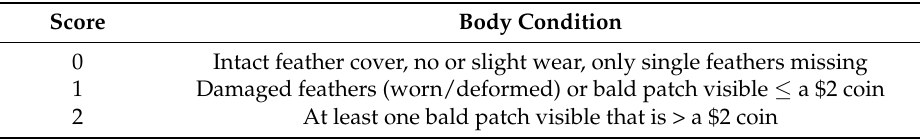
Table 1. The scoring system used by farmers on-site to evaluate the feather condition and amount of feather damage present in their flock. Body areas scored were limited to the back/rump. Score Body Condition 0 Intact feather cover, no or slight wear, only single feathers missing 1 Damaged feathers (worn/deformed) or bald patch visible ≤ a $2 coin 2 At least one bald patch visible that is > a $2